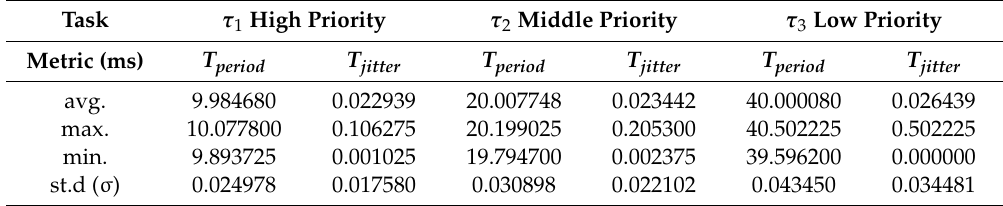
Table 1. Statistical analysis of the periodicity of tasks used in the collision warning system. Task τ 1 High Priority τ 2 Middle Priority τ 3 Low Priority T